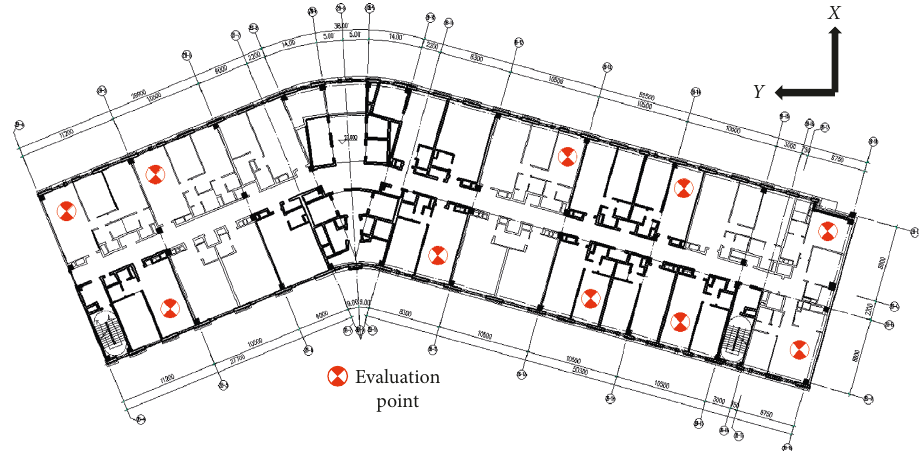
Figure 12: The plan view of the evaluation points at typical story (6 th